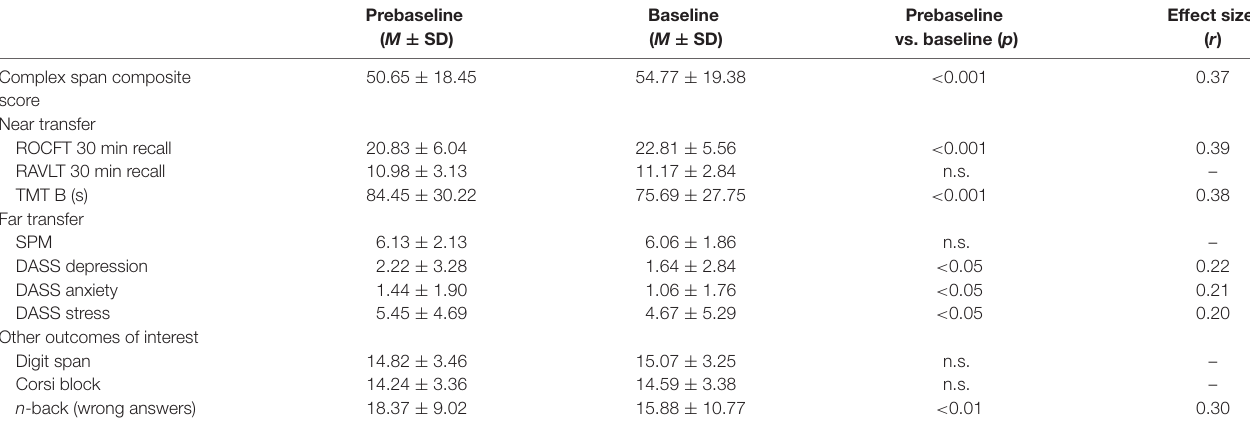
TABLE 3 | Means ( M ), standard deviation (SD), and test statistics comparing prebaseline and baseline session on all outcome measures on the whole group